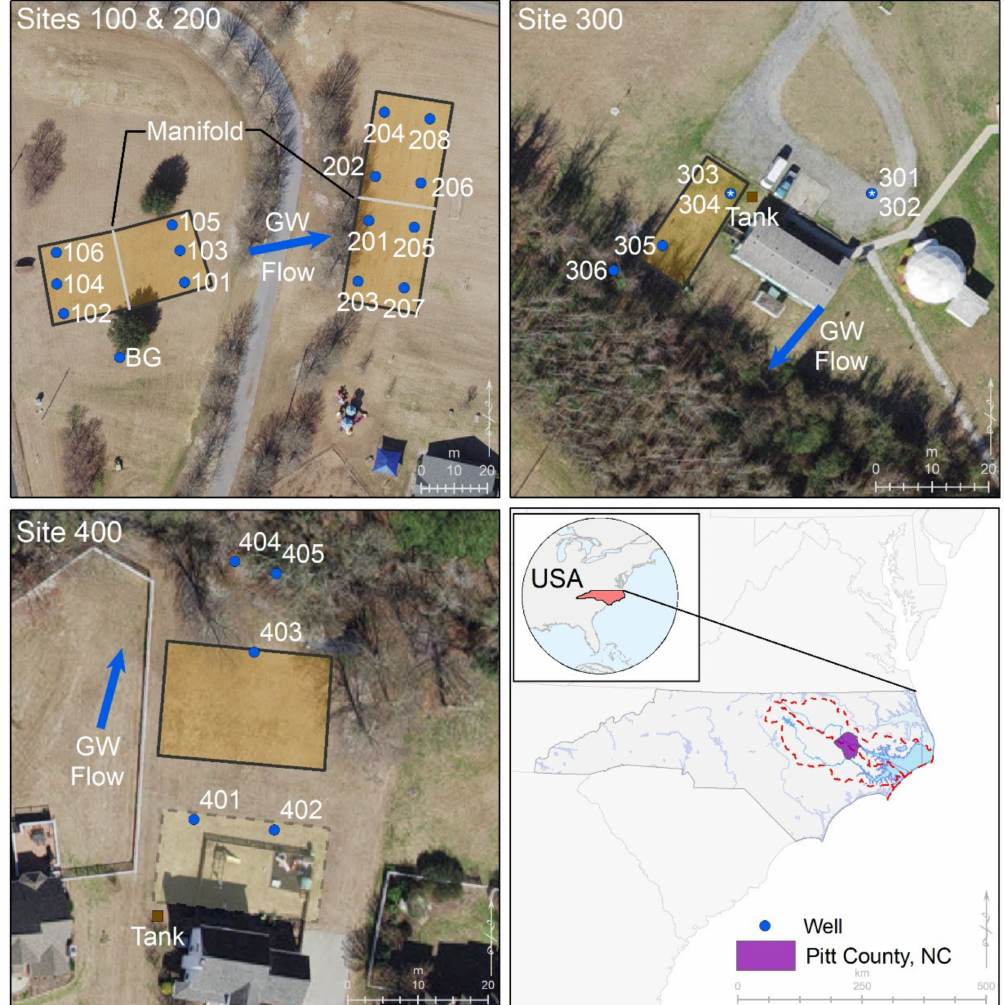
Figure 1. Groundwater monitoring Sites 100 to 400 were located in Pitt County, North Carolina, USA, within the nutrient- sensitive Neuse and Tar-Pamlico River Basins denoted by the dashed line. Drainfield trenches are within the shaded regions of each site. Wells BG, 301, 302, 401 and 402 serve as background groundwater sampling locations for the sites. Wells 404 and 405 are located 15-m down-gradient from the Site 400 drainfield. Other wells (101–106, 201–208, 303–306, 403) are between drainfield trenches or <3 m down-gradient from the drainfields and are considered drainfield